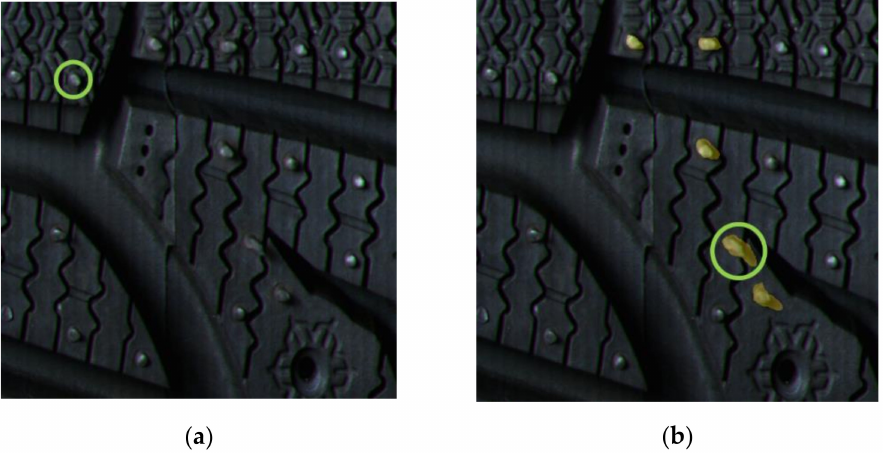
Figure 4. Tire tread image was taken with an RGB camera: ( a ) original image; ( b ) overlapped image with vent spew error label.